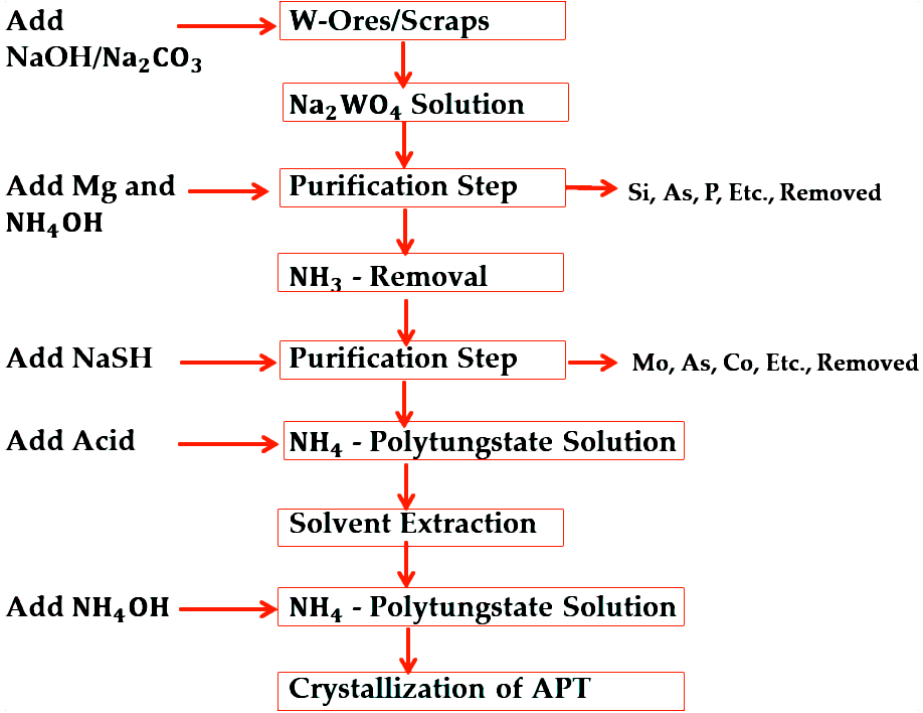
Figure 1. Flow diagram of tungsten hydrometallurgical process [3].